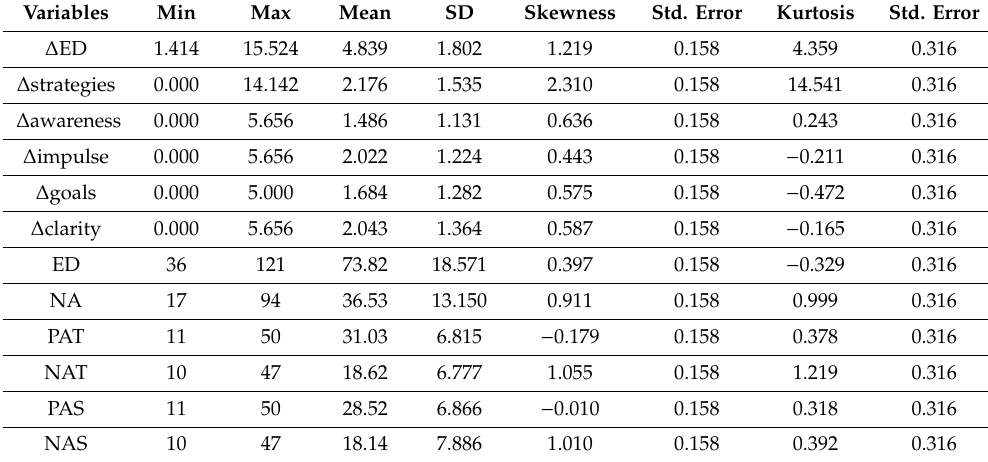
Table 5. Descriptive statistics / total sample ( n =